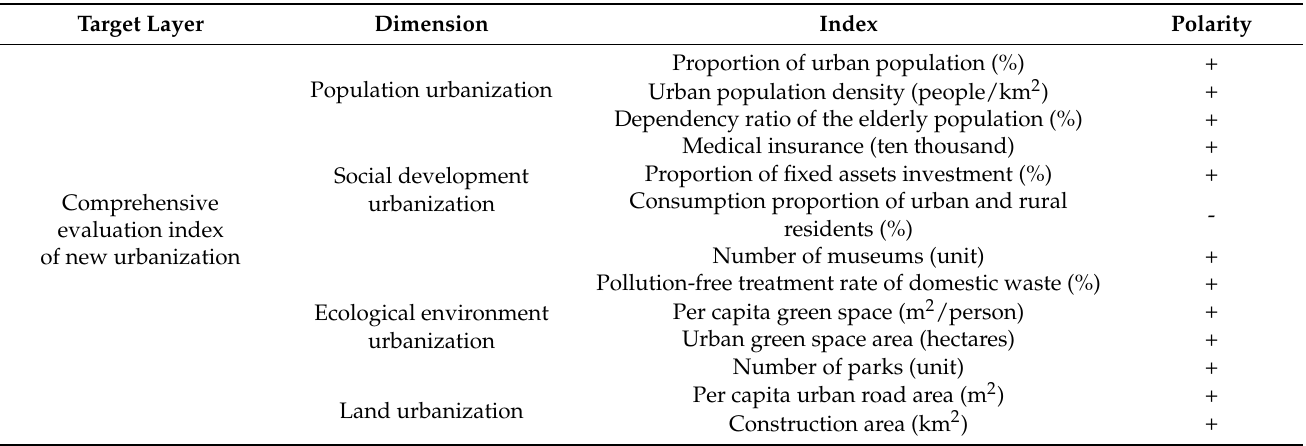
Table 1. The comprehensive evaluation index system of the new urbanization levels. Target